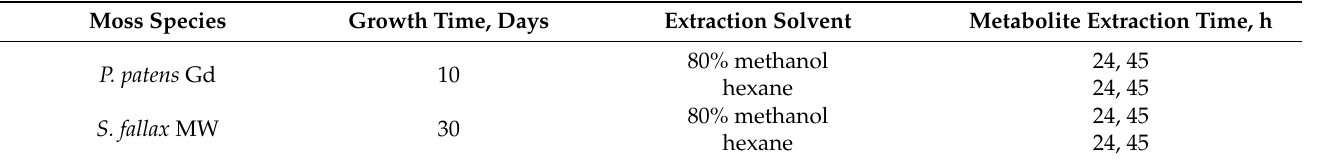
Table 1. Moss growth and intracellular metabolite extraction